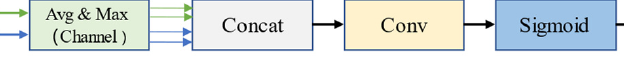
Figure 9. Channel Attention